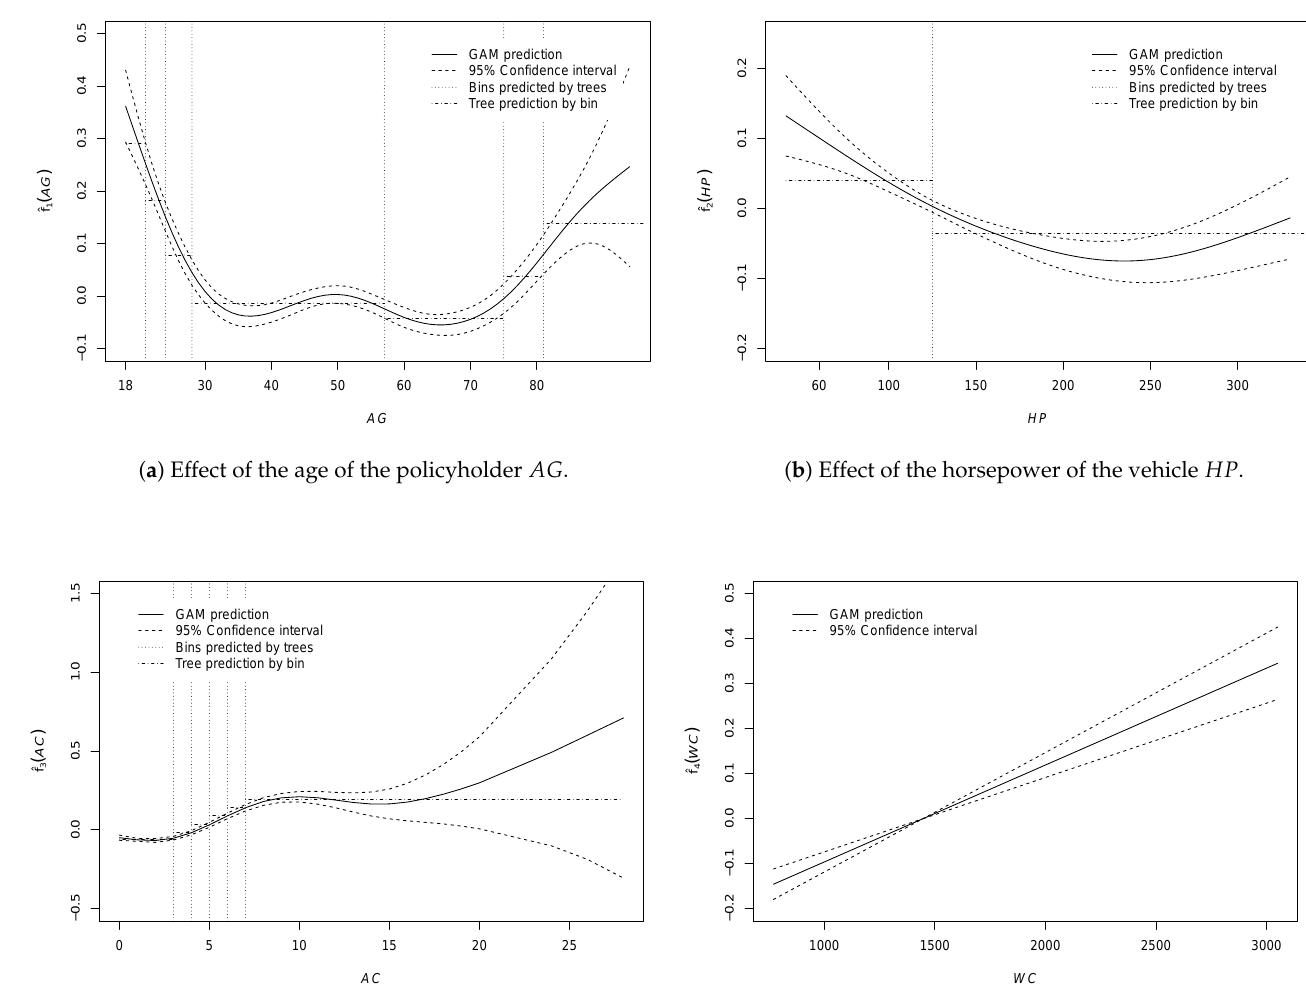
( d ) Effect of the weight of the car WC .